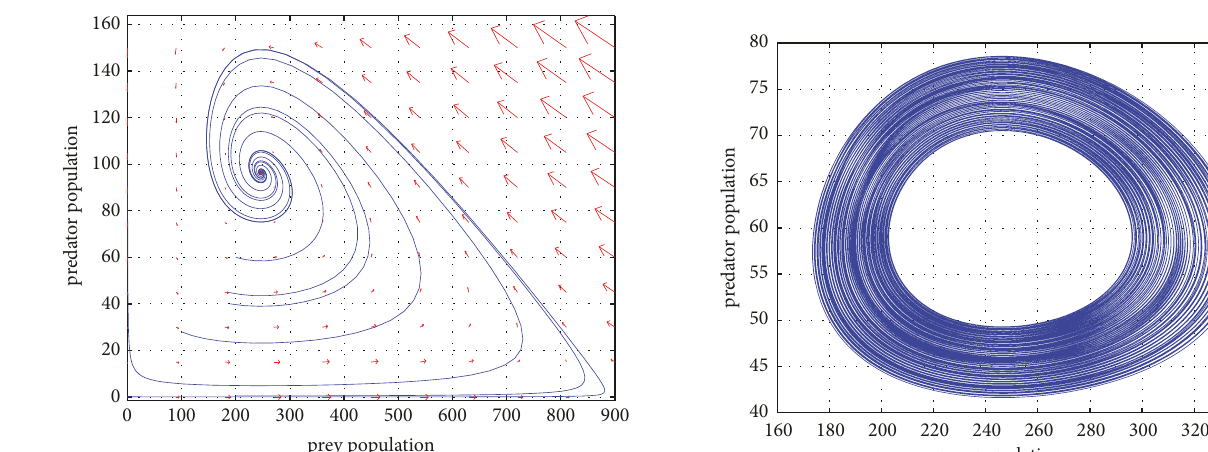
= (𝑥 , 𝑦 ) is locally asymptotically ∗ ∗ ∗